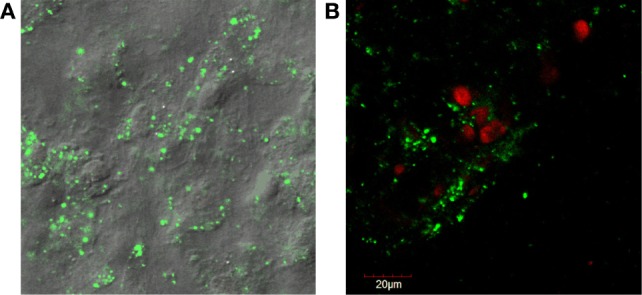
(A) Fluorescent confocal microscopy images of dental pulp cell tissue particles showing sheets of cells held together by extracellular matrix. Rounded, raised areas are nuclei and cell borders are indescript due to the attached matrix. The cytoplasm staining green (live) is positive for cell viability (LIVE/DEAD®1). (B) Counter-staining with ethidium homodimer red (dead) shows that some cells are non-viable as the nuclei stain red.1LIVE/DEAD® Viability/Cytotoxicity Kit, Thermo Fisher Scientific, Waltham, MA, USA.